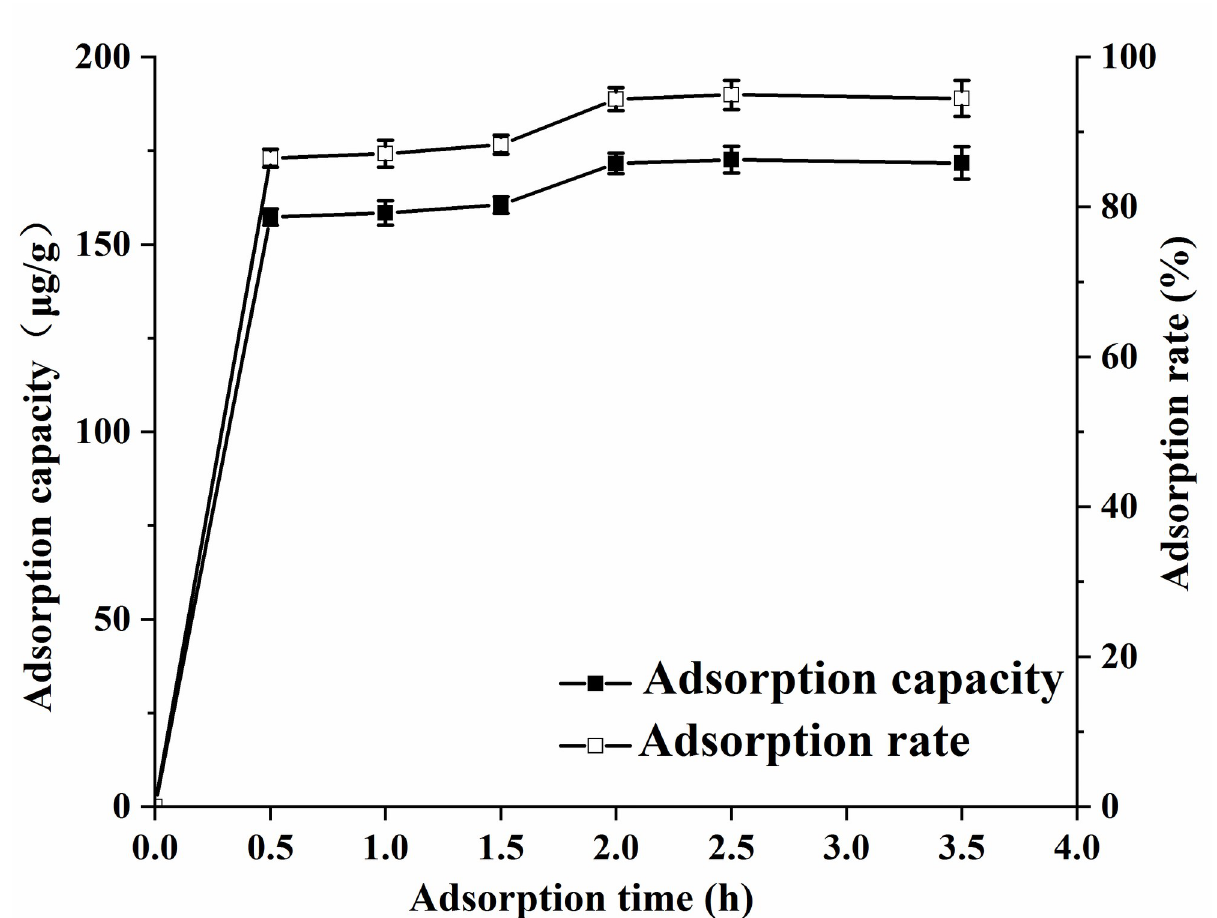
Fig 5. Effect of time on the adsorption of MMS to AFB1.